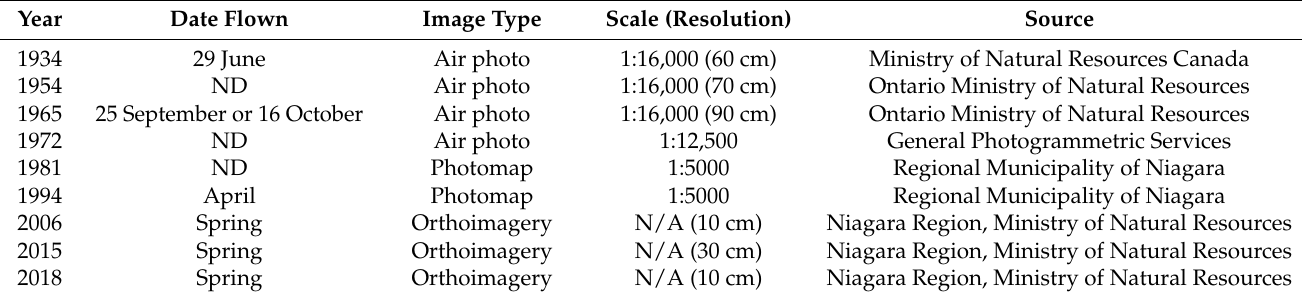
Figure 3. A summary diagraph of the five sequential steps of Phase One of the methodological approach. Table 1. Details of the aerial imagery selected for the Lincoln case study. All aerial images had the same projection: NAD 1983 UTM Zone